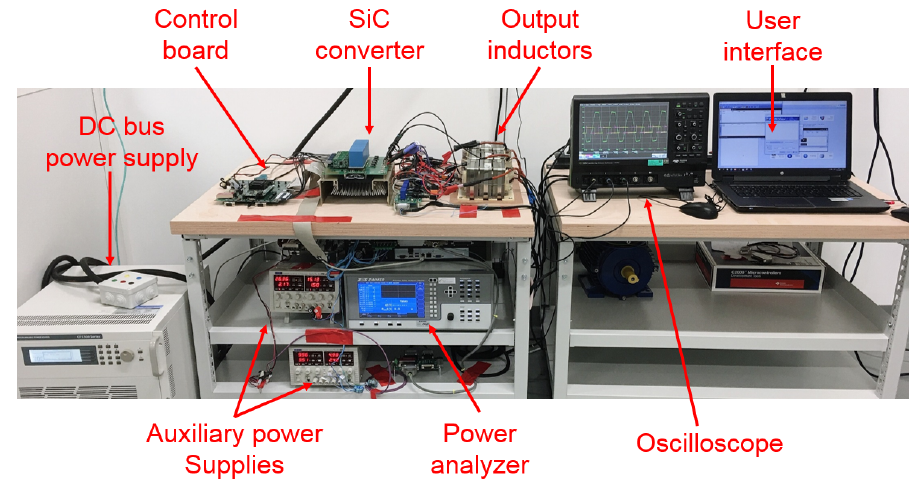
Figure 11. Experimental set-up to measure losses in three-phase SiC inverter.